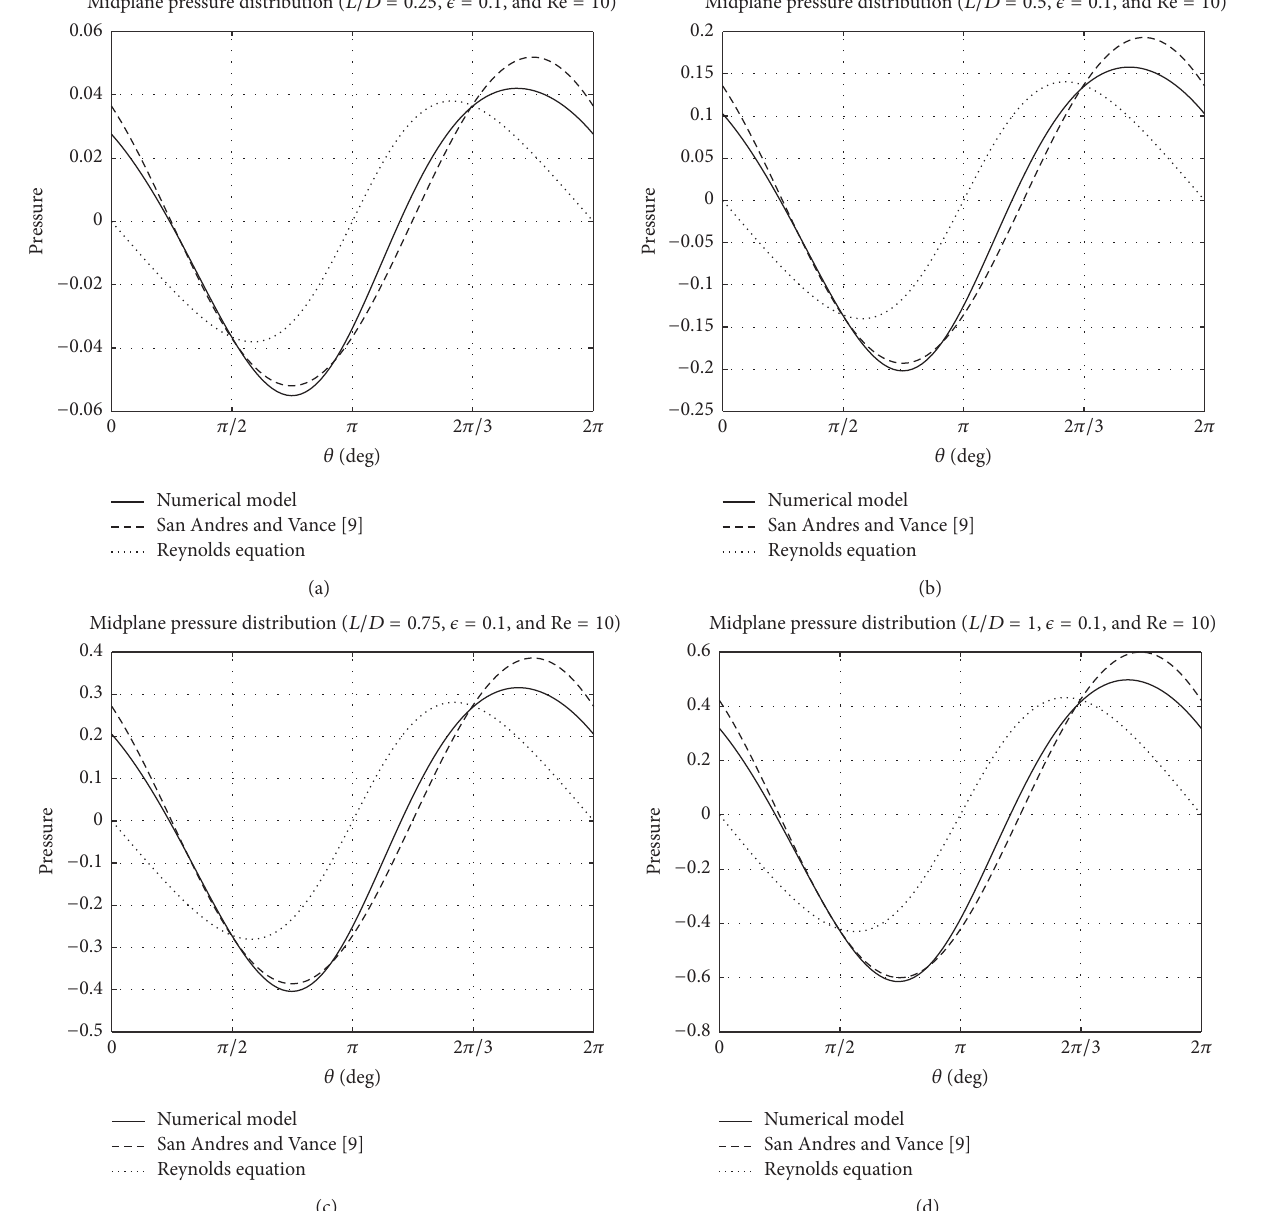
Figure 5: The effect of SFD journal slenderness ration on the dimensionless pressure